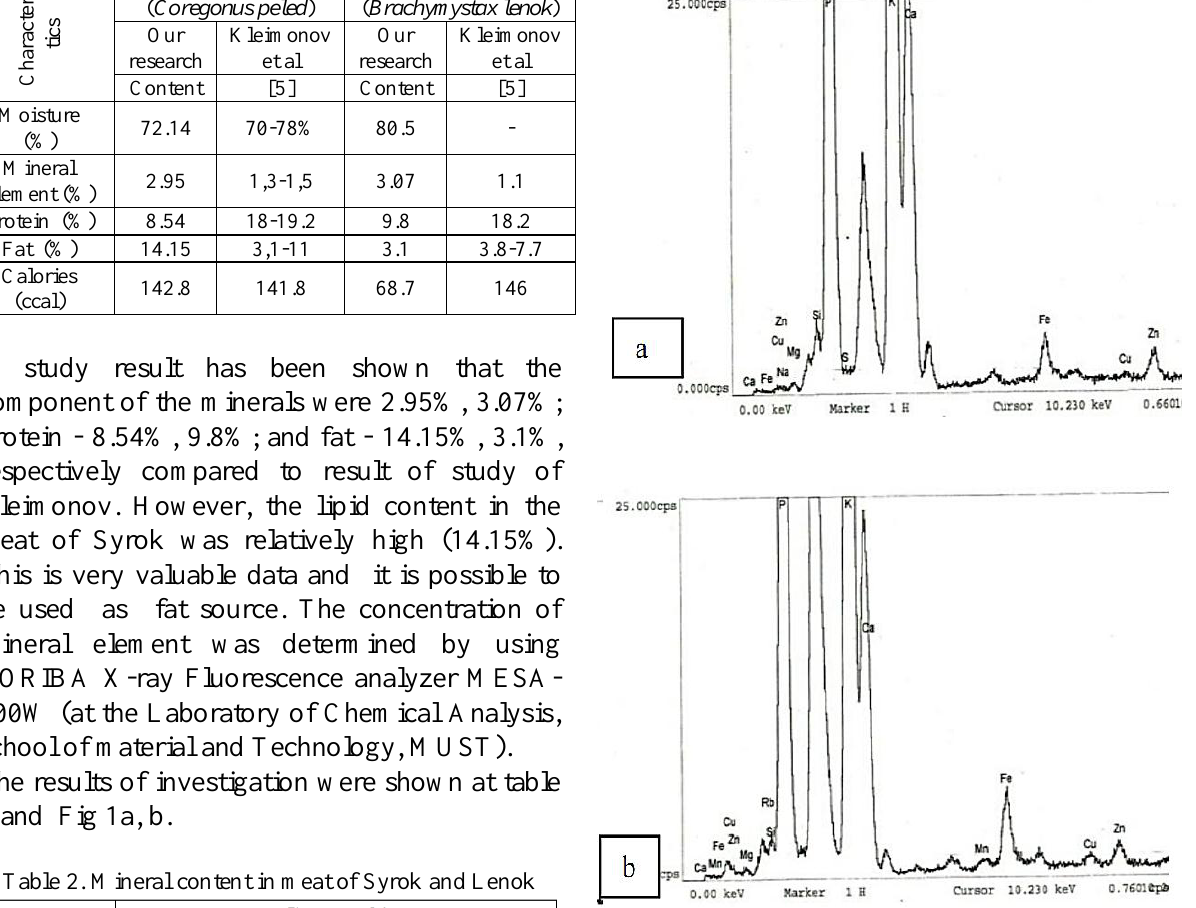
Figure 1. X-ray Fluorescence spectrum in meat of Syrok (a), Lenok (b)